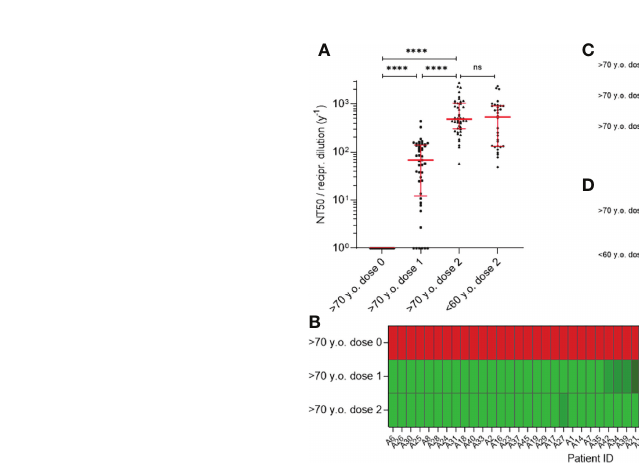
FIGURE 3 | Analysis of neutralization titer (NT50) against SARS-CoV-2 WT using sera from participants older than 70 years (n = 45) before vaccination (dose 0), after fi rst- (dose 1), and after second vaccination (dose 2) with BNT162b2, in contrast to fully vaccinated participants younger than 60 years (n = 32). Neutralization titers are presented as a dilution factor for serum (1:x). (A) Individual NT50 values are shown as individual progressions for each person until full immunization with BNT162b2. In contrast, individual titers for 50% neutralization are illustrated for people younger than 60 years of age fully vaccinated with BNT162b2. Medians are visualized together with the interquartile range as an error bar. Statistical signi fi cance between values of the three different time points for the group >70 y.o. was determined using the Wilcoxon test. A Mann – Whitney – U test for nonparametric distribution was applied for comparison of immune responses between the two age groups. [p > 0.05 not signi fi cant (ns), and p ≤ 0.0001 (****)]. (B) Heat map for visualization of NT50 progression against SARS-CoV-2 WT before and after vaccination with BNT162b2. Illustrated colors shift from red for a negative- to green for a positive antibody status. (C) Percentages of participants with positive, borderline or negative for half-maximum neutralization against SARS-CoV-2 WT are shown for time points before-, after the fi rst and second vaccination. (D) Comparison of percentages of persons older than 70 years and people younger than 60 years with positive, borderline or negative half-maximum neutralization of SARS-CoV-2 WT virus.